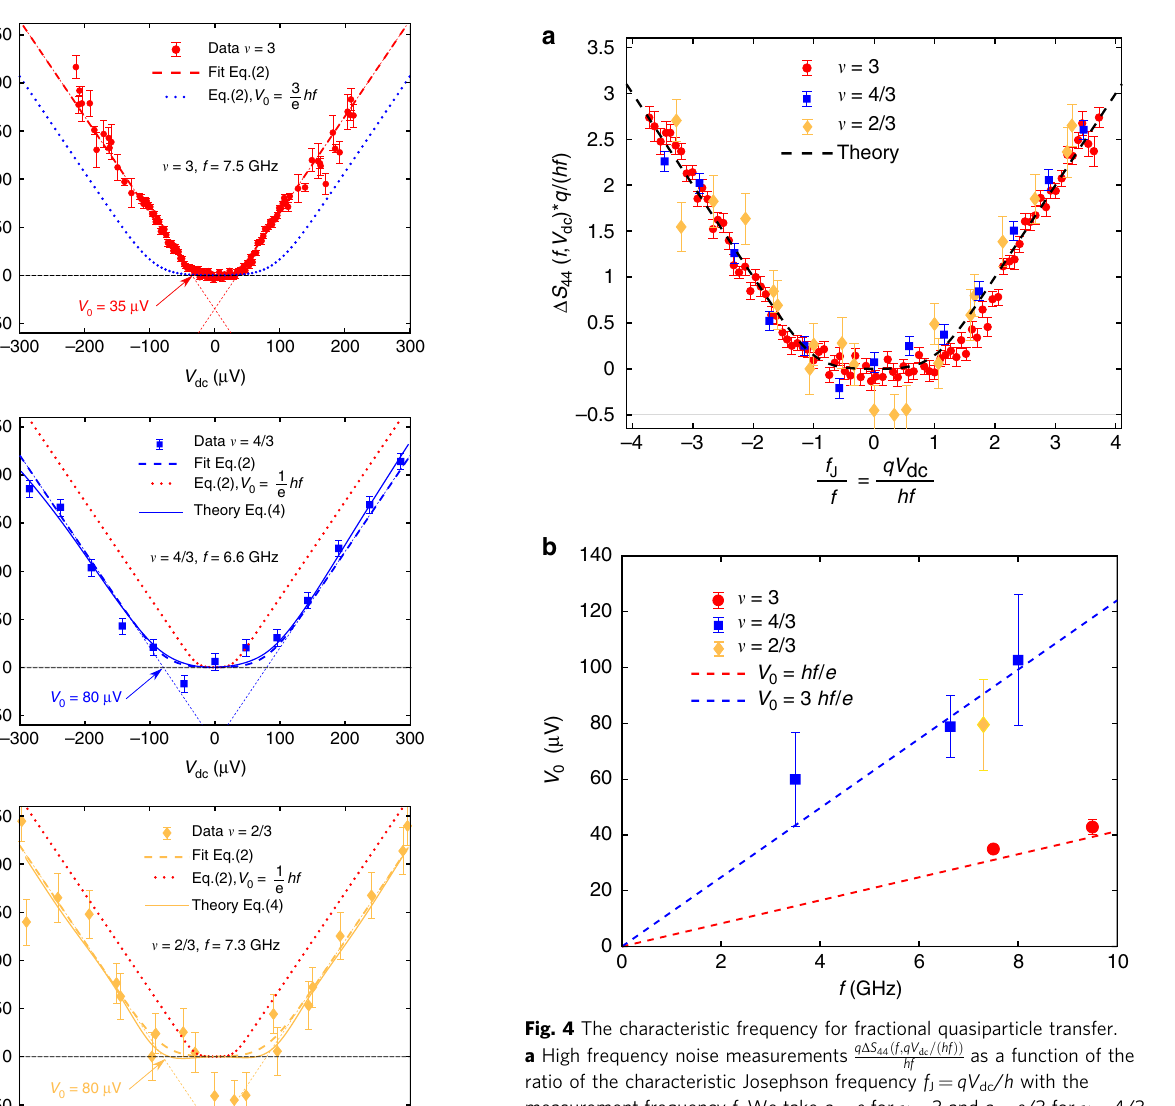
and horizontal axes, taking q = e for ν = 3 and q = e /3 for ν = 4/3 and ν = 2/3. As can be seen from Fig. 4a, all data collapse, within experimental error bars, on the same trace (black dashed line) given by Eq. (2) with a threshold f J / f = 1. In order to check the consistency of our results for various measurement frequencies f , we plot in Fig. 4b the emission thresholds extracted from all our data points as a function of f (see Supplementary Note 3 for additional measurements). In the integer case, the measured thresholds V 0 fall on the red dashed line representing electron transfer: V 0 = hf / e . In contrast, the thresholds measured in the